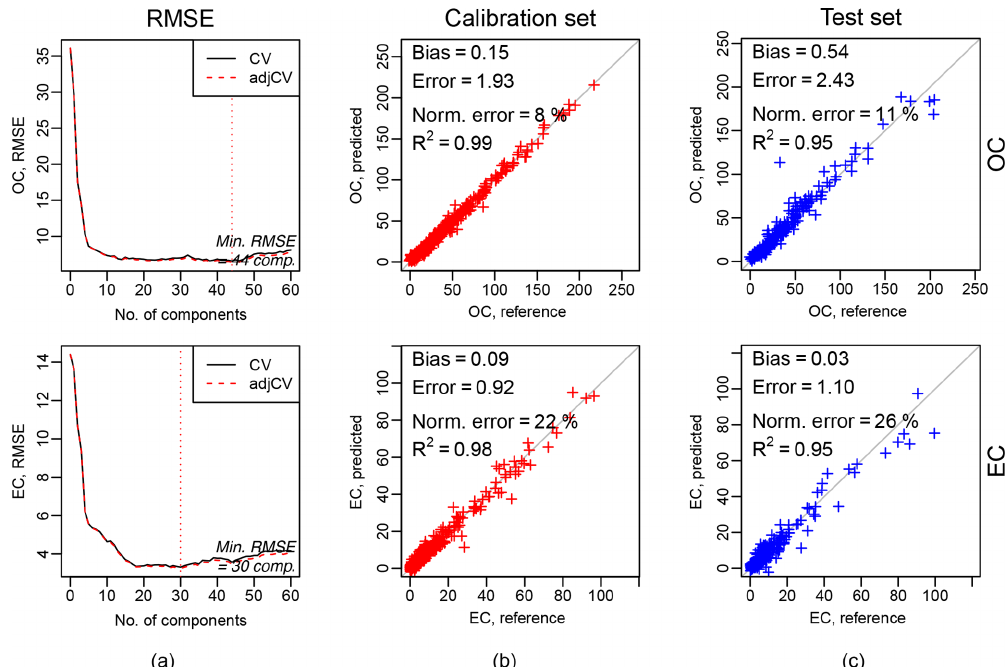
Figure 6. Calibration package. Example of calibration output. (a) RMSE in cross-validation against the number of components (latent variables), and the dotted vertical line indicates the number of components selected according to the minimum RMSE. (b) and (c) indicate scatterplots of predicted against observed (or reference) values for the calibration and test datasets